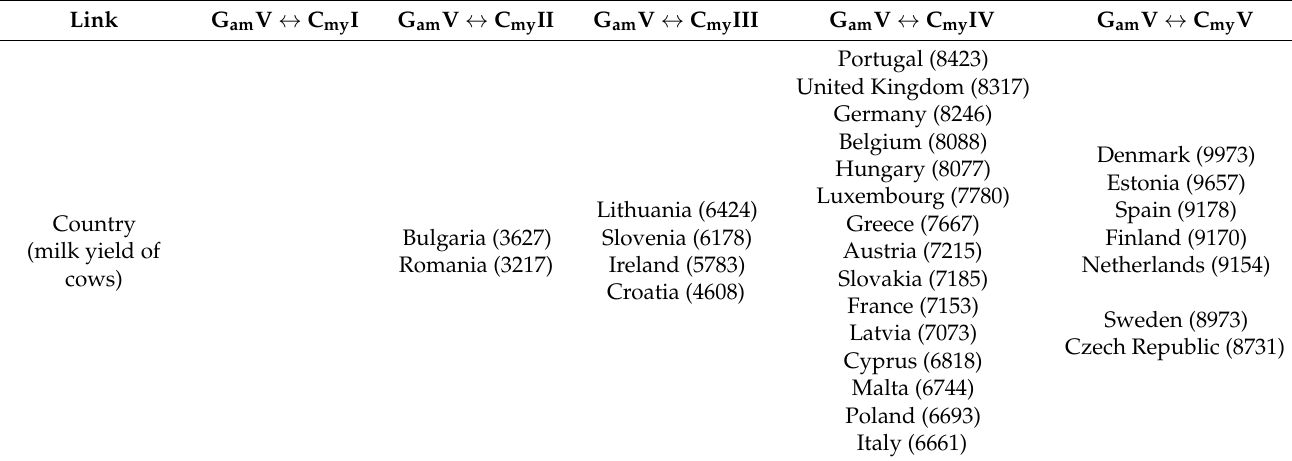
Table 6. Assessment of convergence of the implementation of the fifth generation (G am V) of milking equipment with biological progress (milk yield of cows) in the European Union and United Kingdom